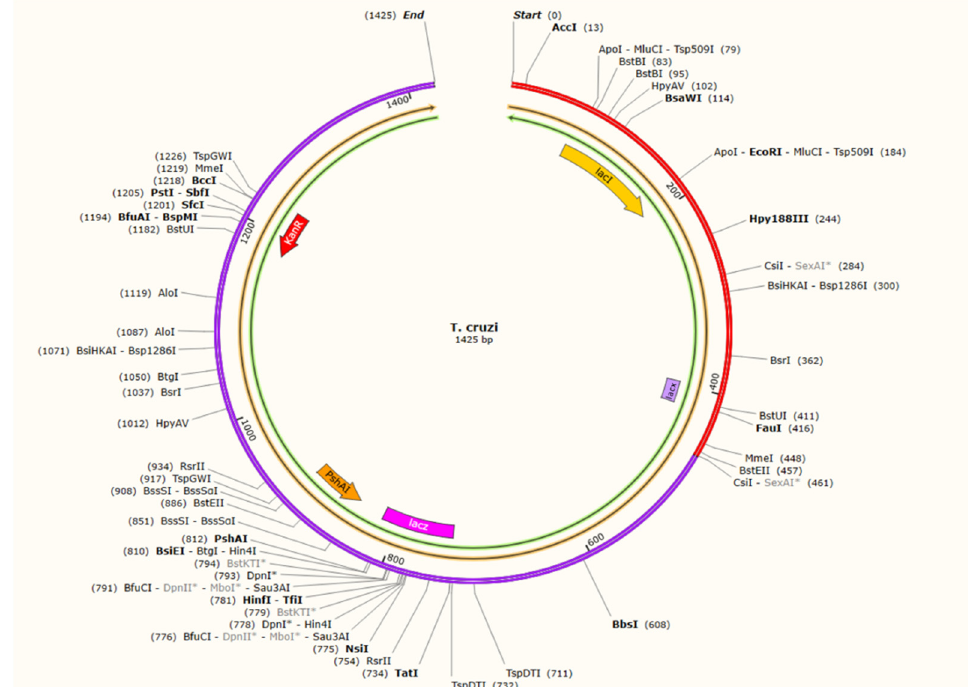
Vaccines 2022 , 10 , 1669 Figure 14. The vaccine was cloned into the pET − 28a (+) vector. Figure 14. The vaccine was cloned into the pET − 28a (+) vector.